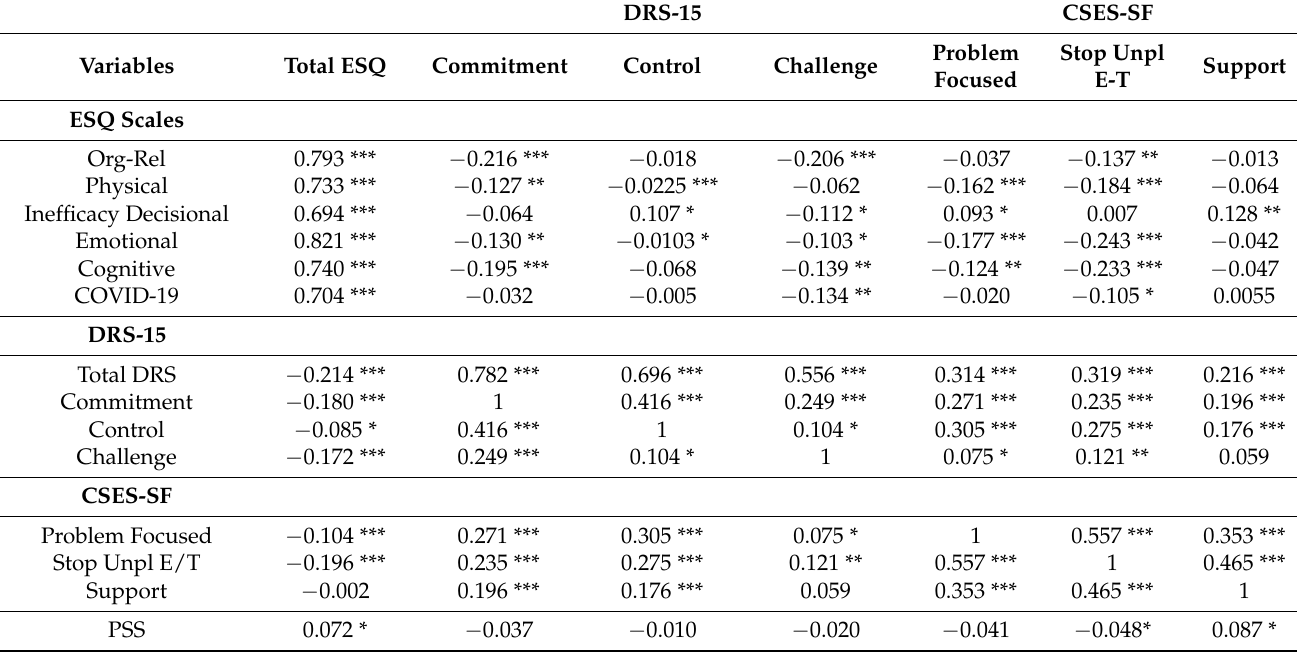
Table 1. Pearson’s correlations between ESQ, DRS-15, CSES-SF and PSS ( n = 500).